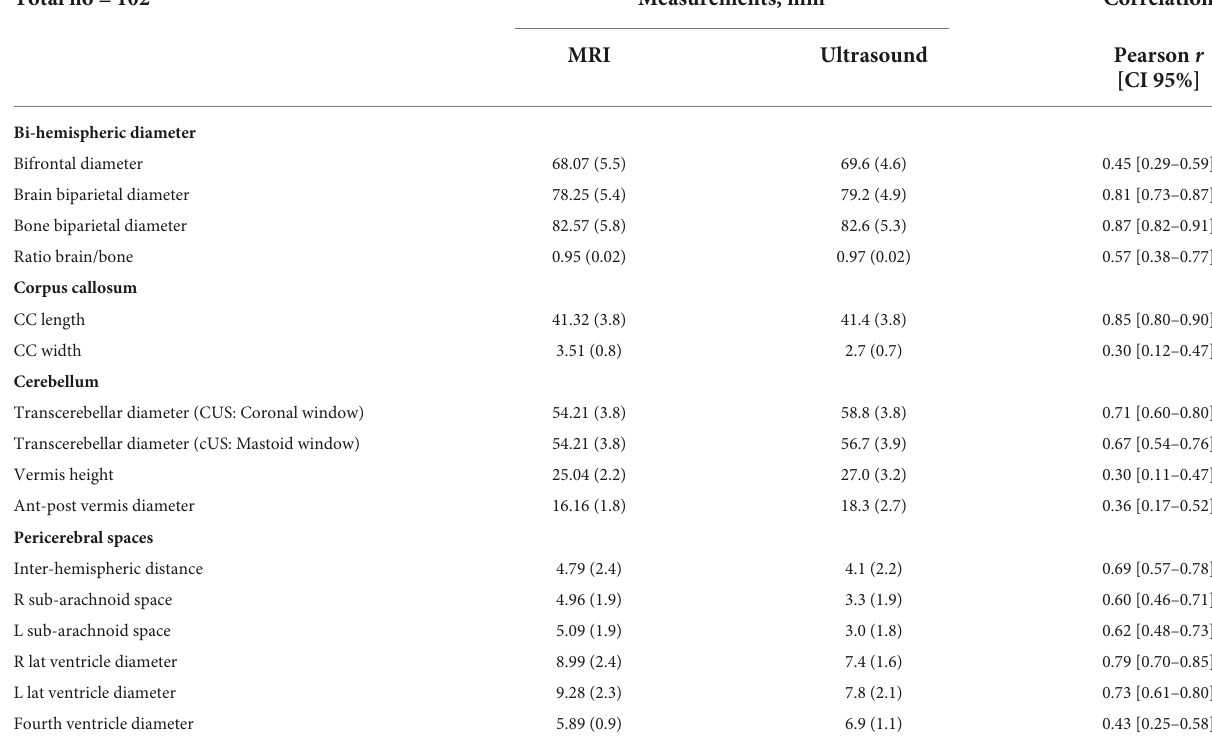
TABLE 3 Comparison of metrics: MRI vs. cUS. Total no =